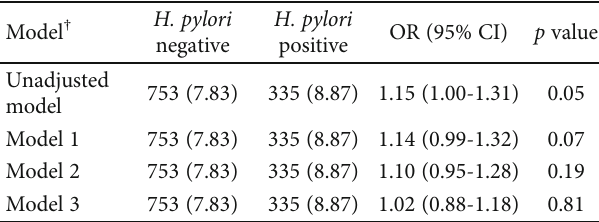
Table 2: Association between H. pylori infection and